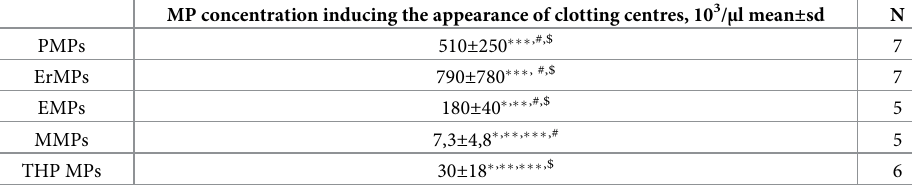
Table 1. The minimal MPs concentrations inducing the appearance of clotting centres. MP concentration inducing the appearance of clotting centres, 10 3 / μ l mean ± sd N